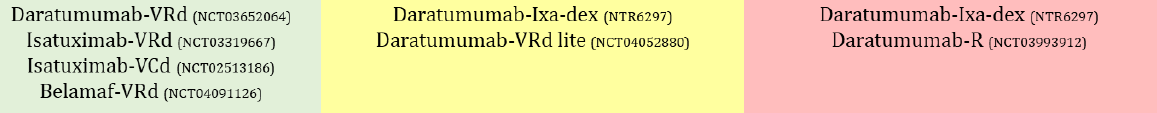
Figure 1. Frailty Assessment. Abbreviations: IMWG, International Myeloma Working Group; ADL, Activities of Daily Living; IADL, Instrumental Activities of Daily Living; CCI, Charlson Comorbidity Index; V, bortezomib; Vd, bortezomib, dexamethasone; VMP, bortezomib, melphalan, prednisone; Rd, lenalidomide, dexamethasone; VRd, bortezomib, lenalidomide, dexamethasone; VRd-lite, VRd with dose-attenuated subcutaneous bortezomib (V); ASCT, autologous stem-cell transplantation; VCd, bortezomib, cyclophosphamide, dexamethasone; Ixa, ixazomib; Belamaf, belantamab mafodotin; pts, patients.